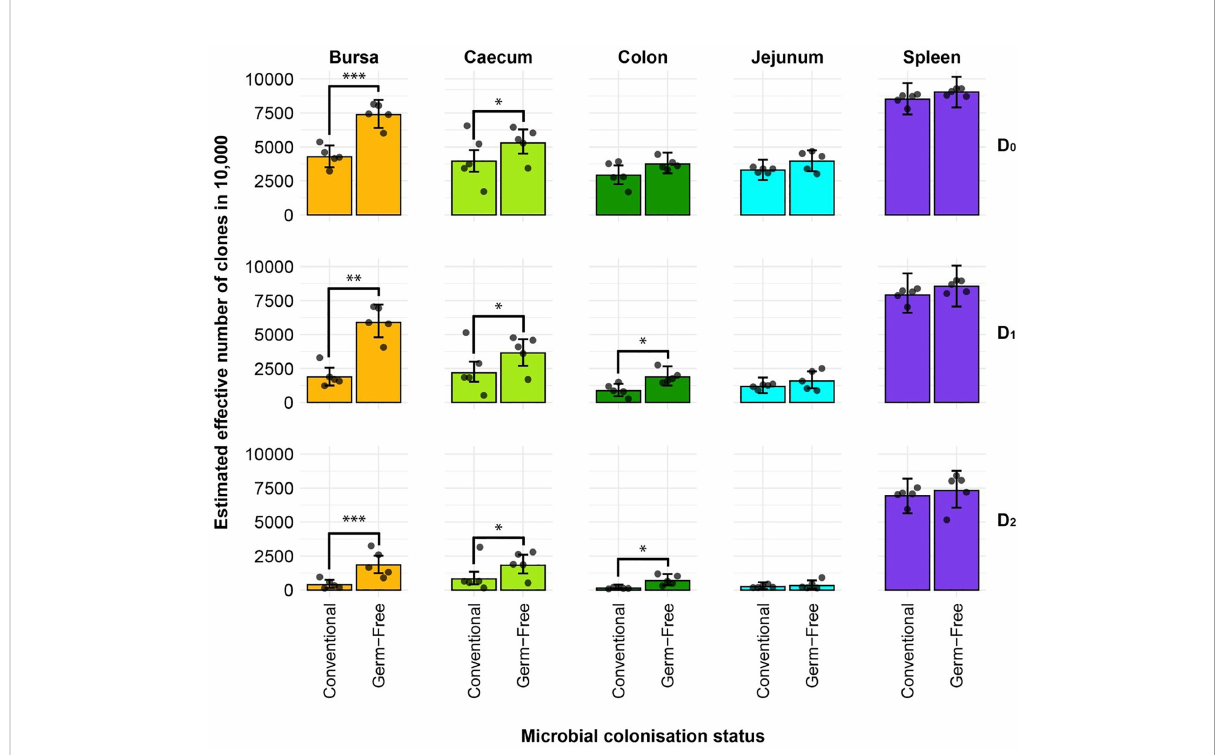
FIGURE 3 Effective diversity within conventional and germ-free samples. Different rows show the effective number of clones corresponding to clonal richness (D 0 ), the typical clones (D 1 ), and dominant clones (D 2 ). Tissues are colour coded for the bursa (orange), caecum (green), colon (dark green), jejunum (light blue), and spleen (purple). Dots represent individual bird observations of the effective number of species calculated in each tissue for the corresponding Hill number values. Error bars show the 95% bootstrap con fi dence intervals for the point estimates generated from 1000 simulations of the model. Statistically signi fi cant differences between the model estimates are depicted above the plots based on their corresponding p-values: *p < 0.05; **p < 0.01, ***p <